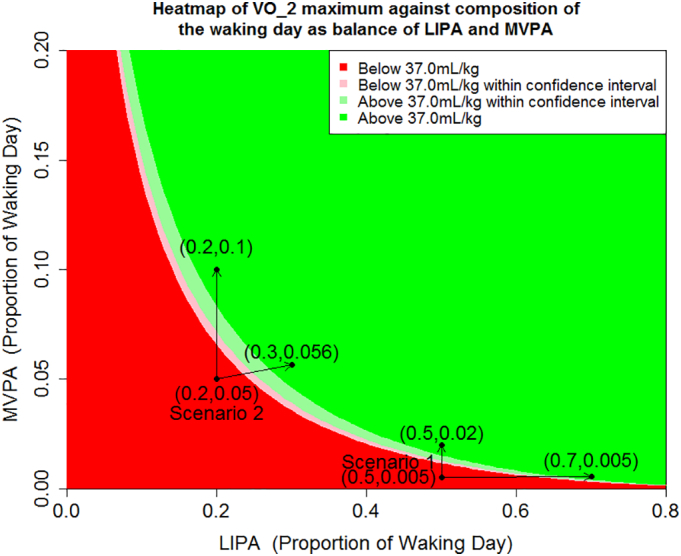
Expected VO2 maximum (and 95% confidence intervals) against combinations of MVPA and LIPA (with the remaining proportion of the waking day made up of SB) for a white British male with degree level education not taking heart medicine and aged 40 with no history of diabetes. The pale regions referred to as within confidence interval are combinations of LIPA and MVPA where the 95% confidence interval for the expected outcome includes the threshold VO2 maximum = 37.0 mL/kg. Based on Health Survey for England 2008.